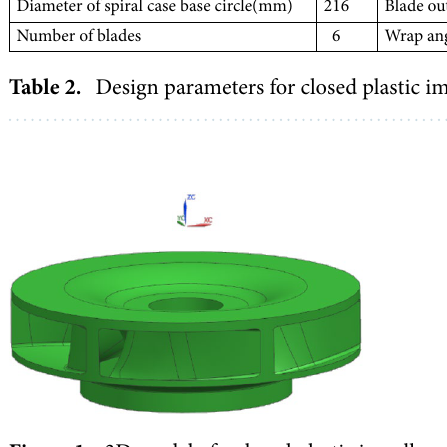
Figure 1. 3D model of a closed plastic